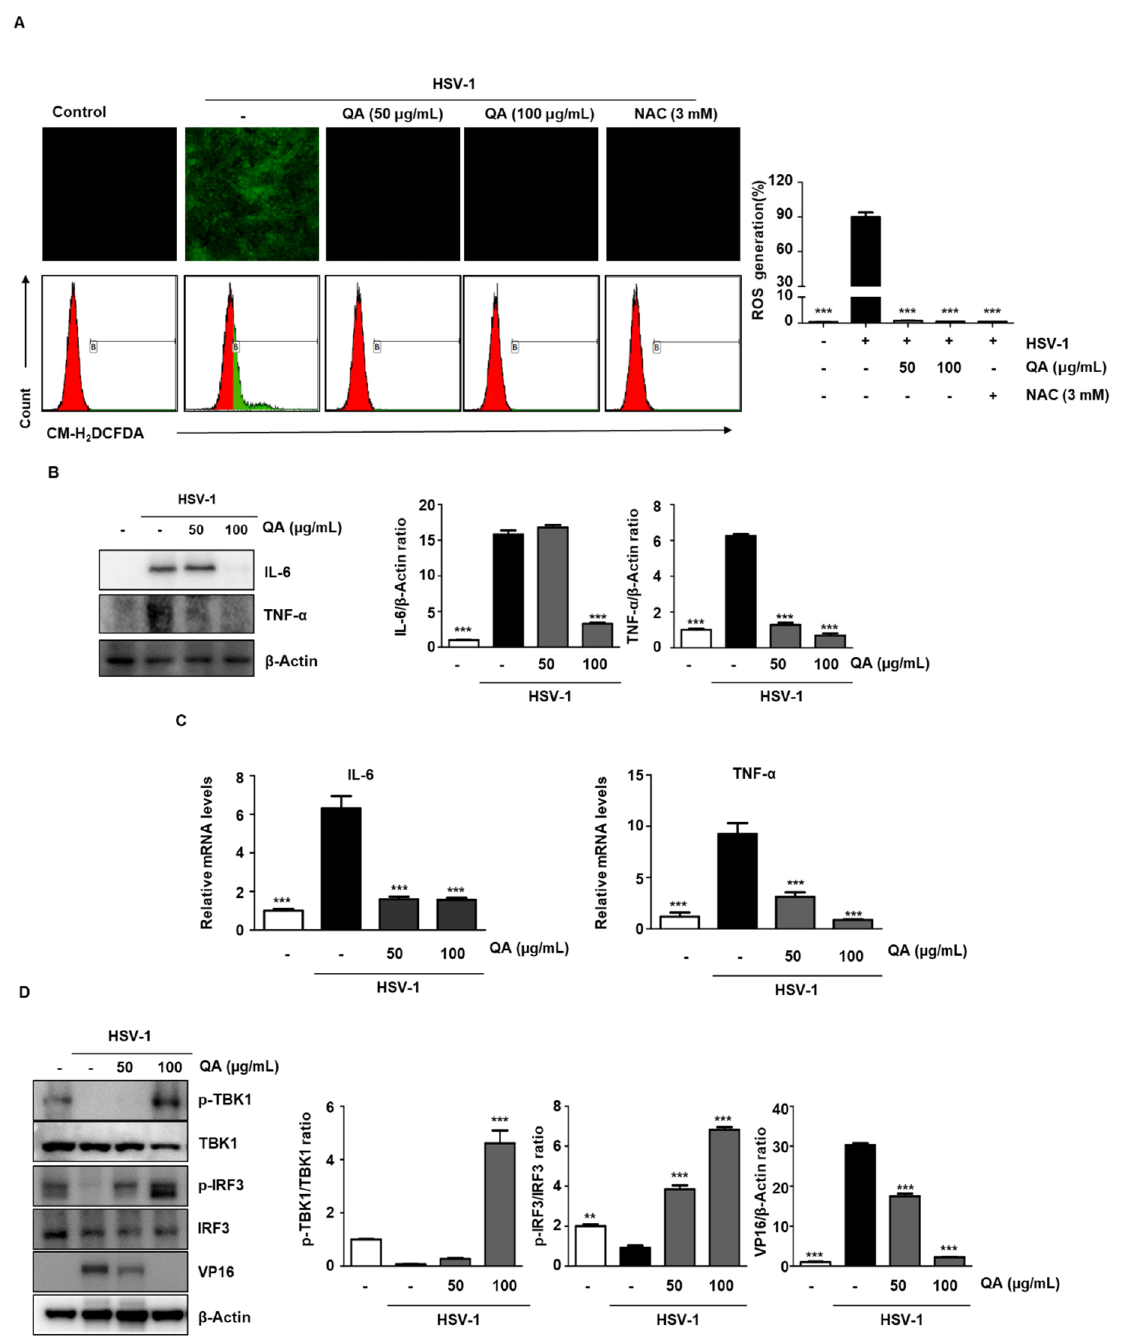
Figure 6. QA treatment inhibits ROS production by HSV-1 infection in SK-N-SH cells. ( A ) SK-N-SH cells were infected with HSV-1 (MOI = 0.01) for 2 h and then treated with QA at 50 and 100 µg/mL and cultured for 30 h. ROS was labeled with DCFH-DA. The level of ROS was measured using flow cytometry. (B-D) SK-N-SH cells were infected with HSV-1 (MOI = 0.01) for 2 h and then treated with QA at 50 and 100 µ g/mL and cultured for 48 h. ( B ) Whole cell extracts were subjected to western blot analysis for TNF- α and IL-6. β -actin was used as an internal control. ( C ) RNA was extracted from SK-N-SH cells, and TNF- α and IL-6 expression was measured by real-time PCR. ( D ) Whole cell extracts were subjected to western blot analysis for p-TBK1, TBK1, p-IRF3, IRF3, and VP16. β -Actin was used to confirm equal sample loading. The data are representative of three independent experiments and quantified as mean values ± SEM. One-way ANOVA with Tukey’s post hoc test; *** p < 0.001, compared with the HSV-1 treatment. Upon HSV-1 infection, activated NF- κ B increases the transcription of proinflamma- tory cytokines and chemokines [26]. Indeed, we confirmed that the expression of IL-6 and